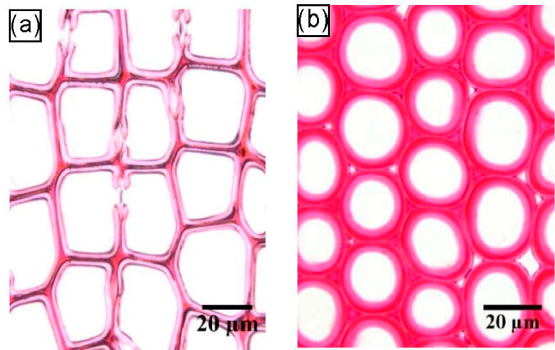
Figure 7. ( a ) Tracheids of Taxodium ‘Zhongshanshan’ normal wood with a square shape, whose cell corners and compound middle lamellae are stained dark red and secondary walls are stained light red; ( b ) tracheids of Taxodium ‘ Zhongshanshan ’ compression wood with a round shape, whose secondary walls are stained in different shades of red with saffron [62].